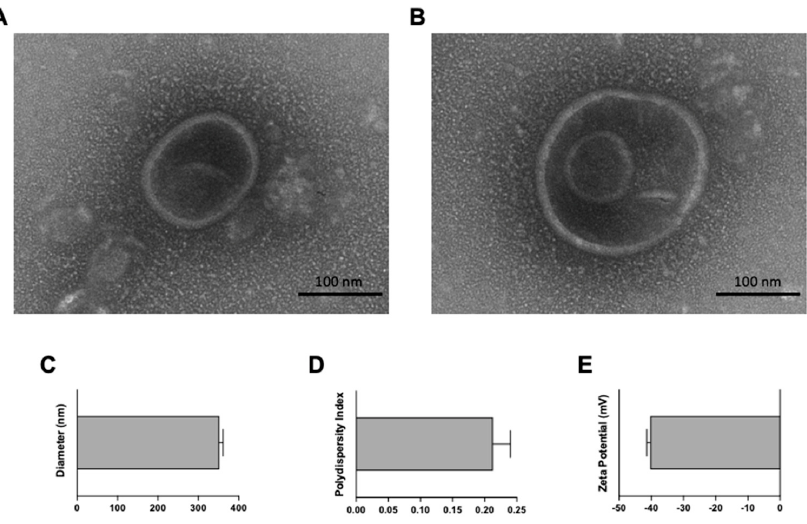
Figure 2. Proteoliposome characterization. Proteoliposome vesicles were observed as monolamellar ( A ) or bilamellar ( B ) rounded vesicles by transmission electron microscopy (TEM) (scale bar = 100 nm). ( C ) Diameter (352.2 ± 8.7 nm), ( D ) polydispersity index (0.213 ± 0.027) and ( E ) Zeta ( ζ ) potential ( − 40.33 ± 1.04 mV) were estimated using NanoBrook 90Plus Zeta equipment. Graphs depict the mean ± SD of 10 consecutive measurements.